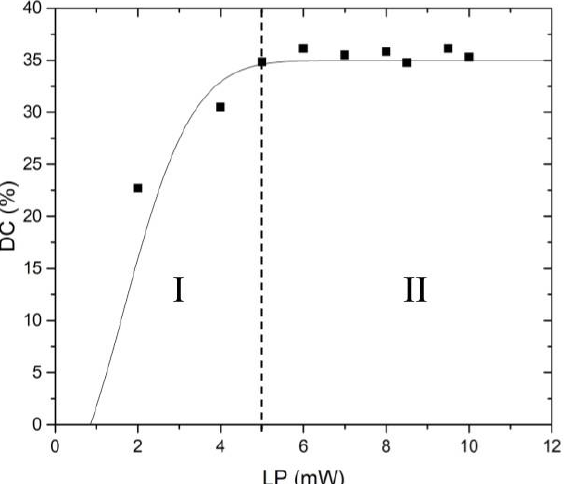
Figure 12. The dependence of conversion degree (DC) on laser power (LP). The solid line shows extrapolation starting from the threshold power of 0.9 mW. The dotted line separates regions I and II, where region I corresponds to conversion degree growth and region II corresponds to conversion degree.